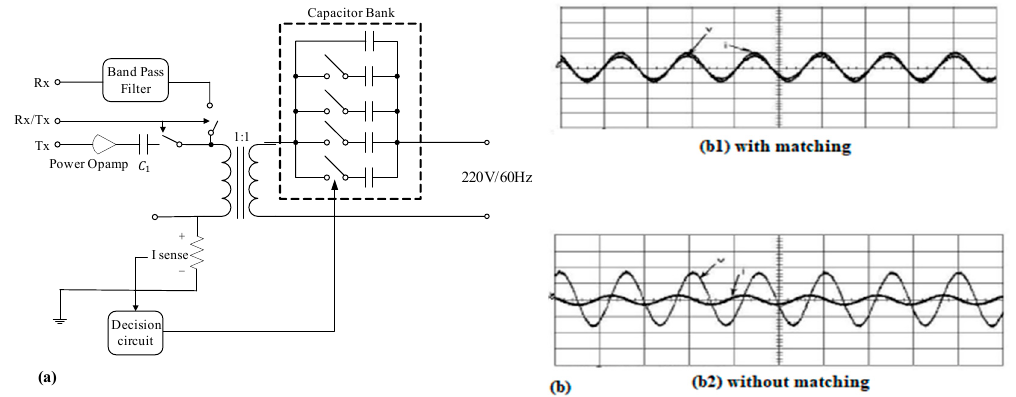
Figure 2. ( a ) Adaptive impedance matching based on capacitors bank [73]; ( b ) comparison of output signal voltage and current for the transmission with and without matching [73].